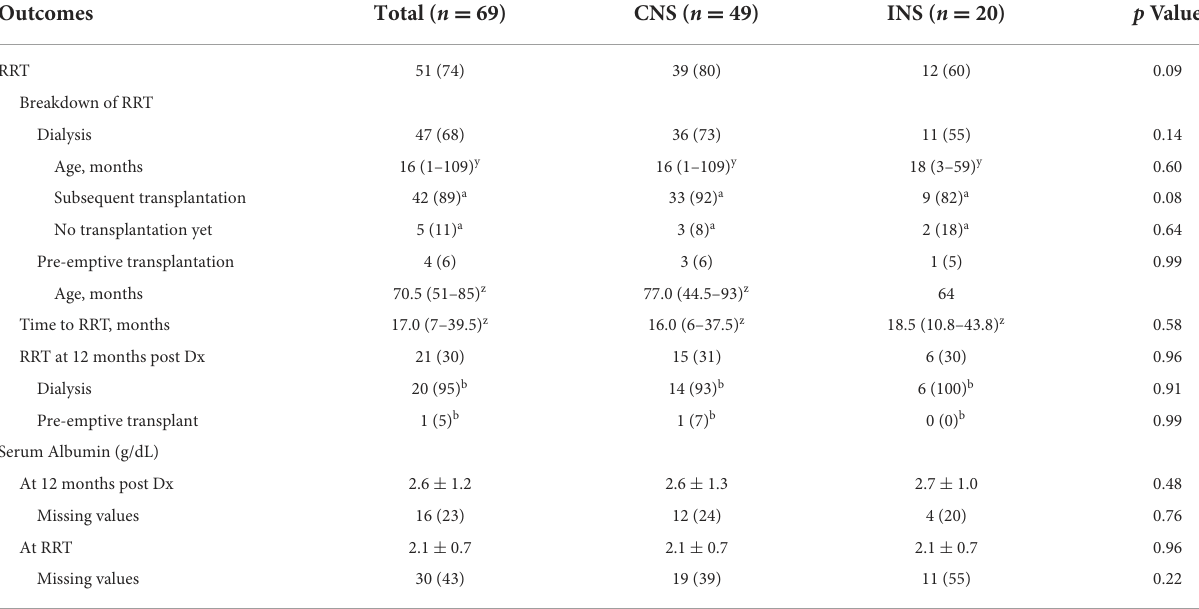
TABLE 4 Outcomes in children with CNS and INS.